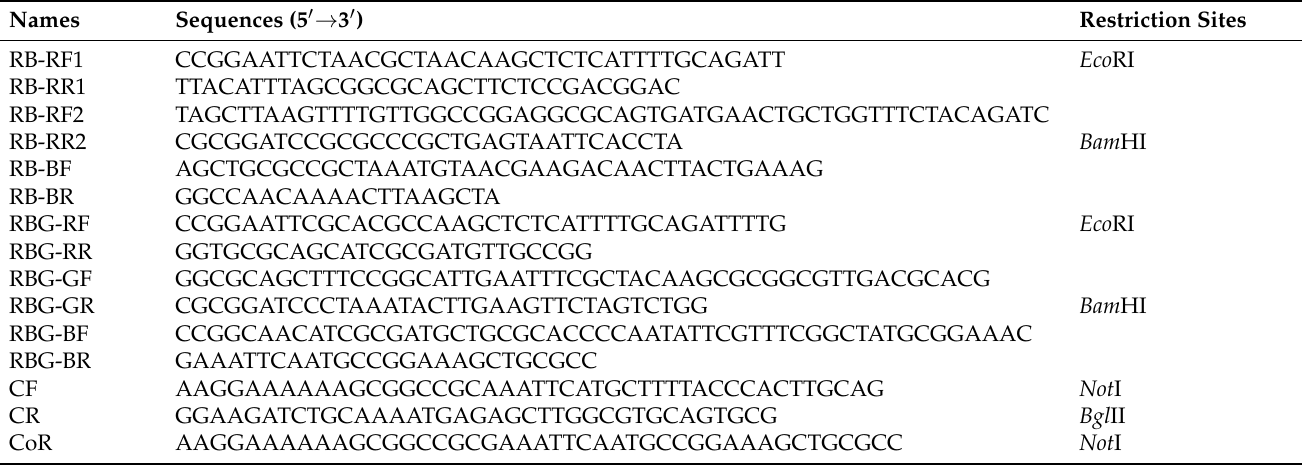
Table 2. Primers used in this